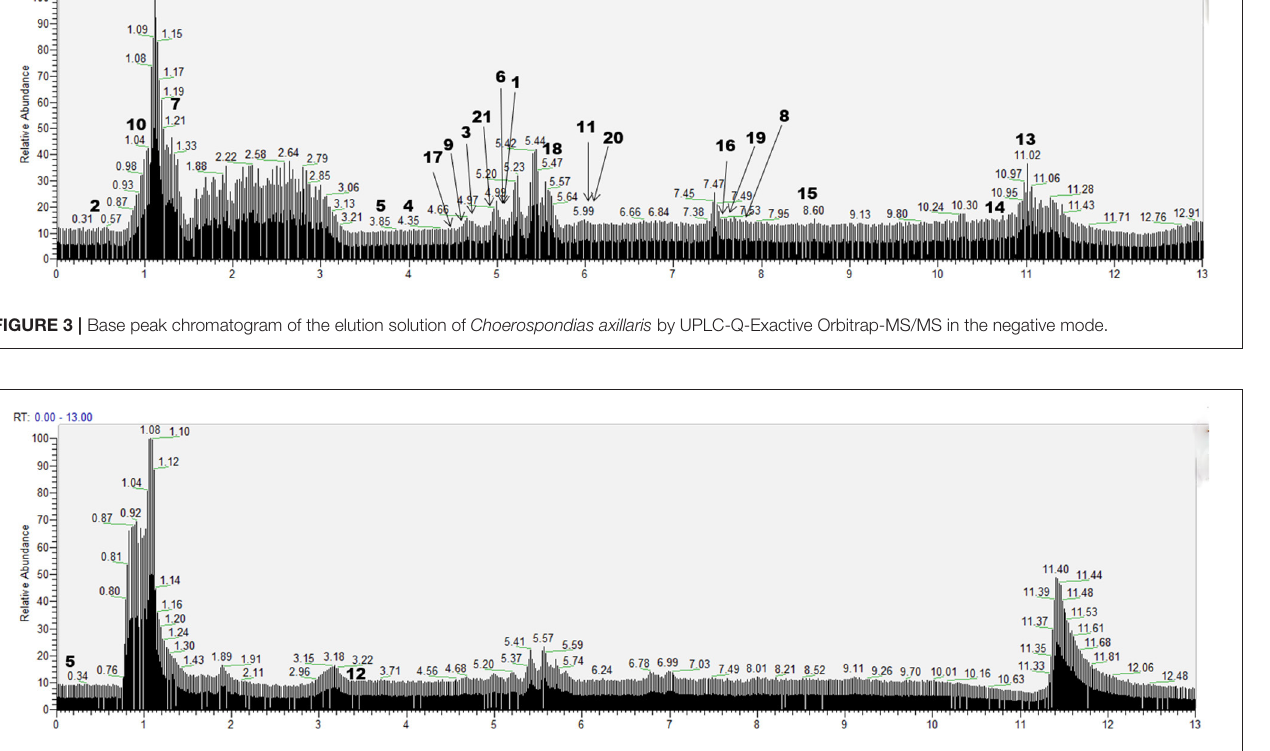
FIGURE 4 | Base peak chromatogram of the elution solution of Choerospondias axillaris by UPLC-Q-Exactive Orbitrap-MS/MS in the positive